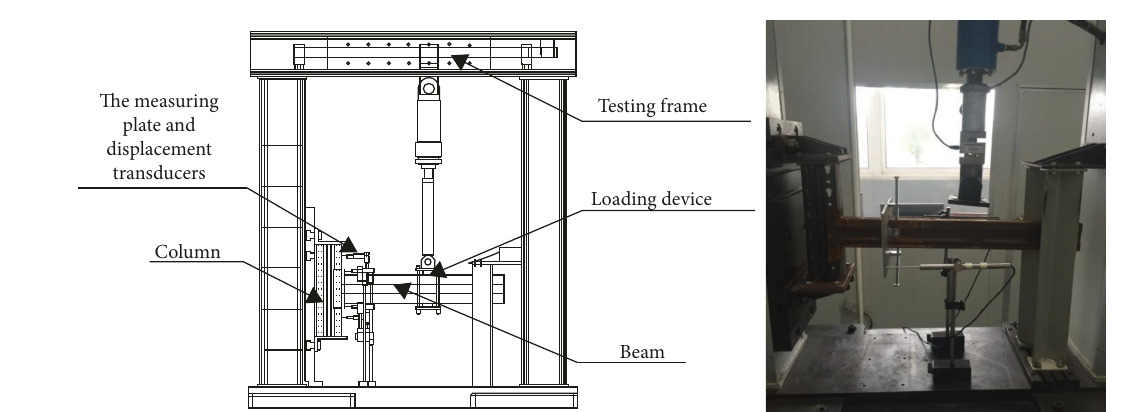
Figure 3: The test